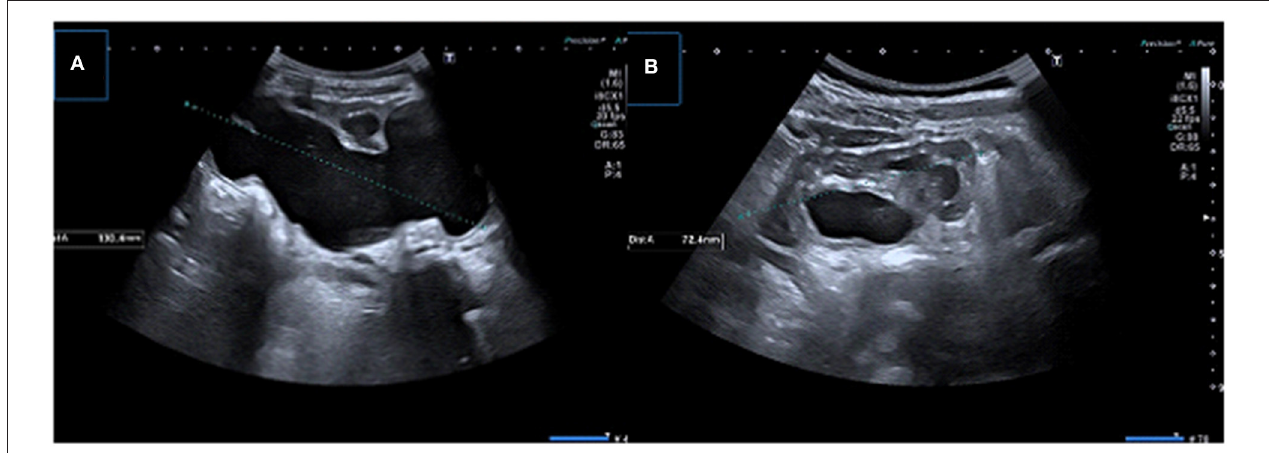
FIGURE 10 | (A) Longitudinal US image in a 1-month-old boy infant showing significant dilation of the pelvicalyceal system with parenchymal thinning (B) Control US image obtained after pyeloplasty demonstrates significant resolution of